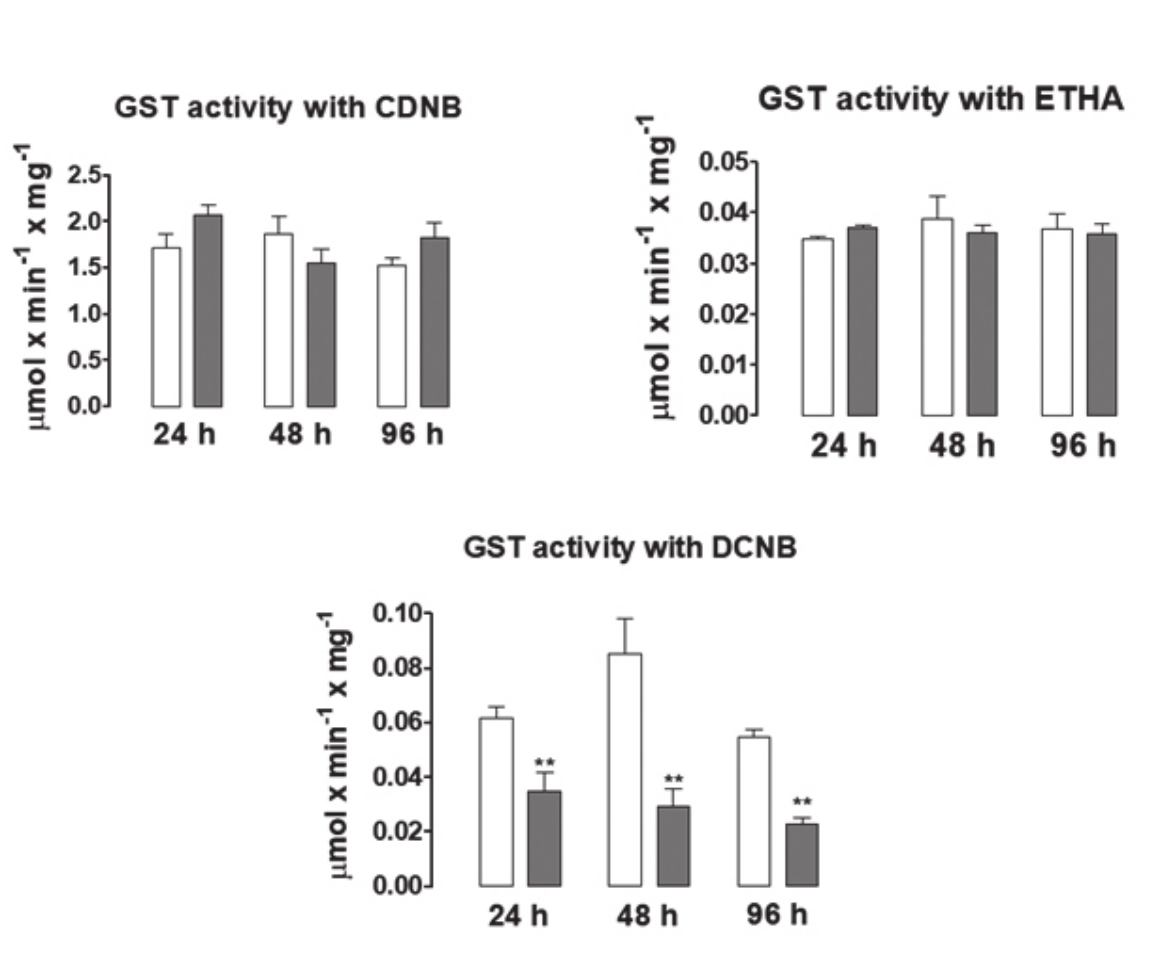
FIGURE 1 | GST specific activities in liver cytosol from Piaractus mesopotamicus injected with methyl parathion (8 mg kg -1 ). Assays were carried out with 1-chloro-2,4-dinitrobenzene (CDNB), ethacrynic acid (ETHA) or 2- dichloro-4-nitrobenzene (DCNB) at 24, 48 and 96 hours after the injection. Bars represent the means ± S.E.M. of assays from five fish injected with corn oil (clear) or methyl parathion (dark grey). Significant differences from controls are indicated as **(P <